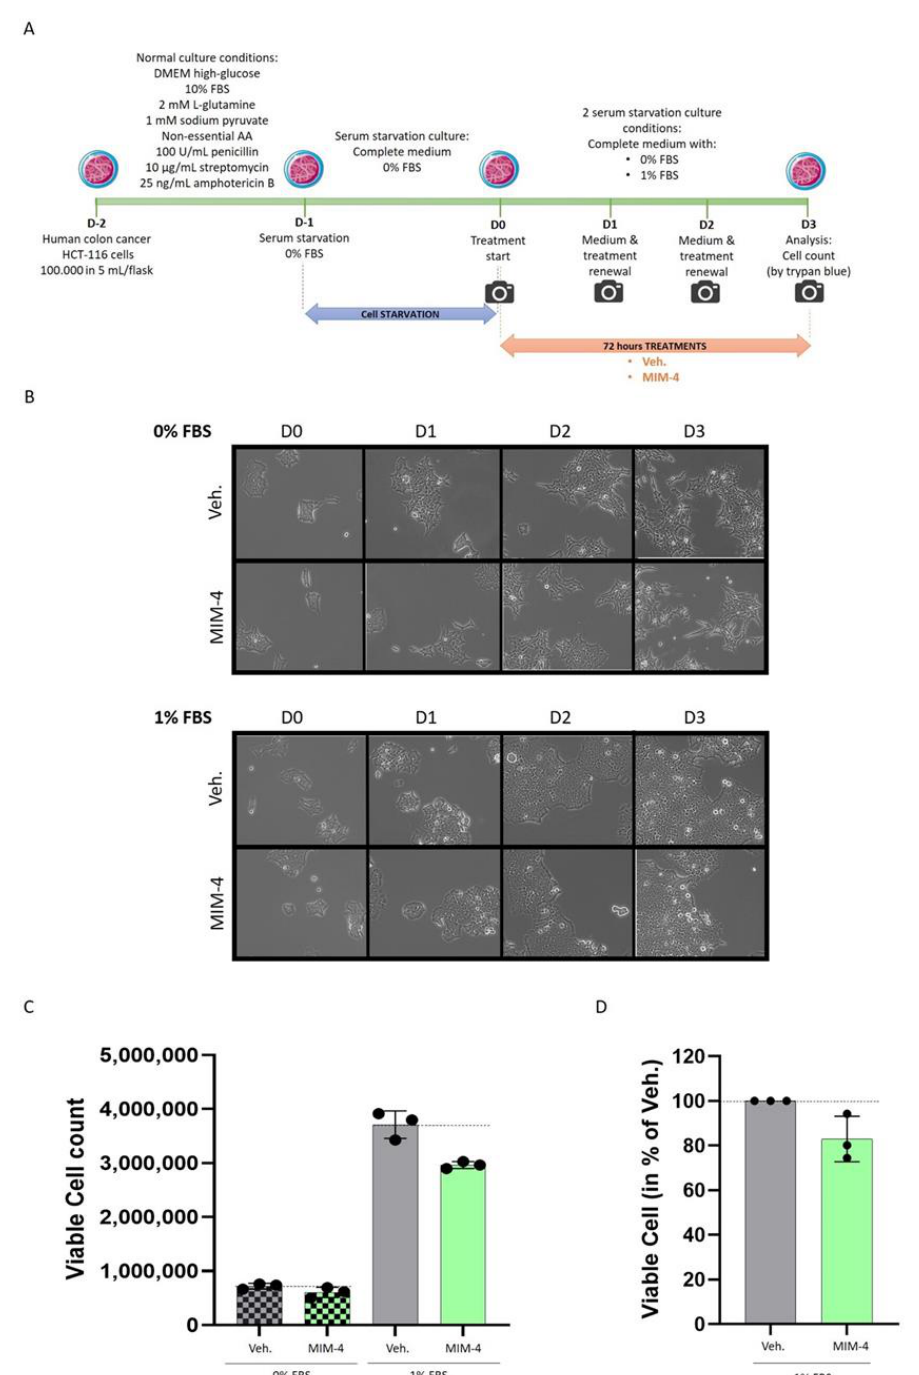
Figure 2. MIM-4 displays slight anti-proliferative effects on colon carcinoma cells cultivated in 2D, under starvation. ( A ) Representative scheme of the experimental protocol. HCT-116 cells were serum-starved for 24 h, and then treated with either MIM-4 or Veh. for a period of 72 h. The medium and the treatments were freshly renewed every day during the course of the treatment. The cells were kept in a starved state, by being supplemented or not with only 1% FBS. AA: amino acids. ( B ) Pictures were taken every day and representative pictures, taken with Evos XL Transmitted light microscope at the x 20 magnification, are presented. ( C ) Viable cells were manually counted by the trypan blue exclusion method at the end of the treatment. This experiment was performed once, and the results are presented as the mean ± SD of viable cell counts, repeated three times, as technical replicates. The black dot line was drawn in the graph to better visualize the effect of MIM-4 compared to its Veh. control. ( D ) The graph shows the results of the two experiments performed as the percentage of viable cells normalized on the respective Veh. (set to 100%). Each black dot represents the normalized results for one tested MIM-4 capsule.